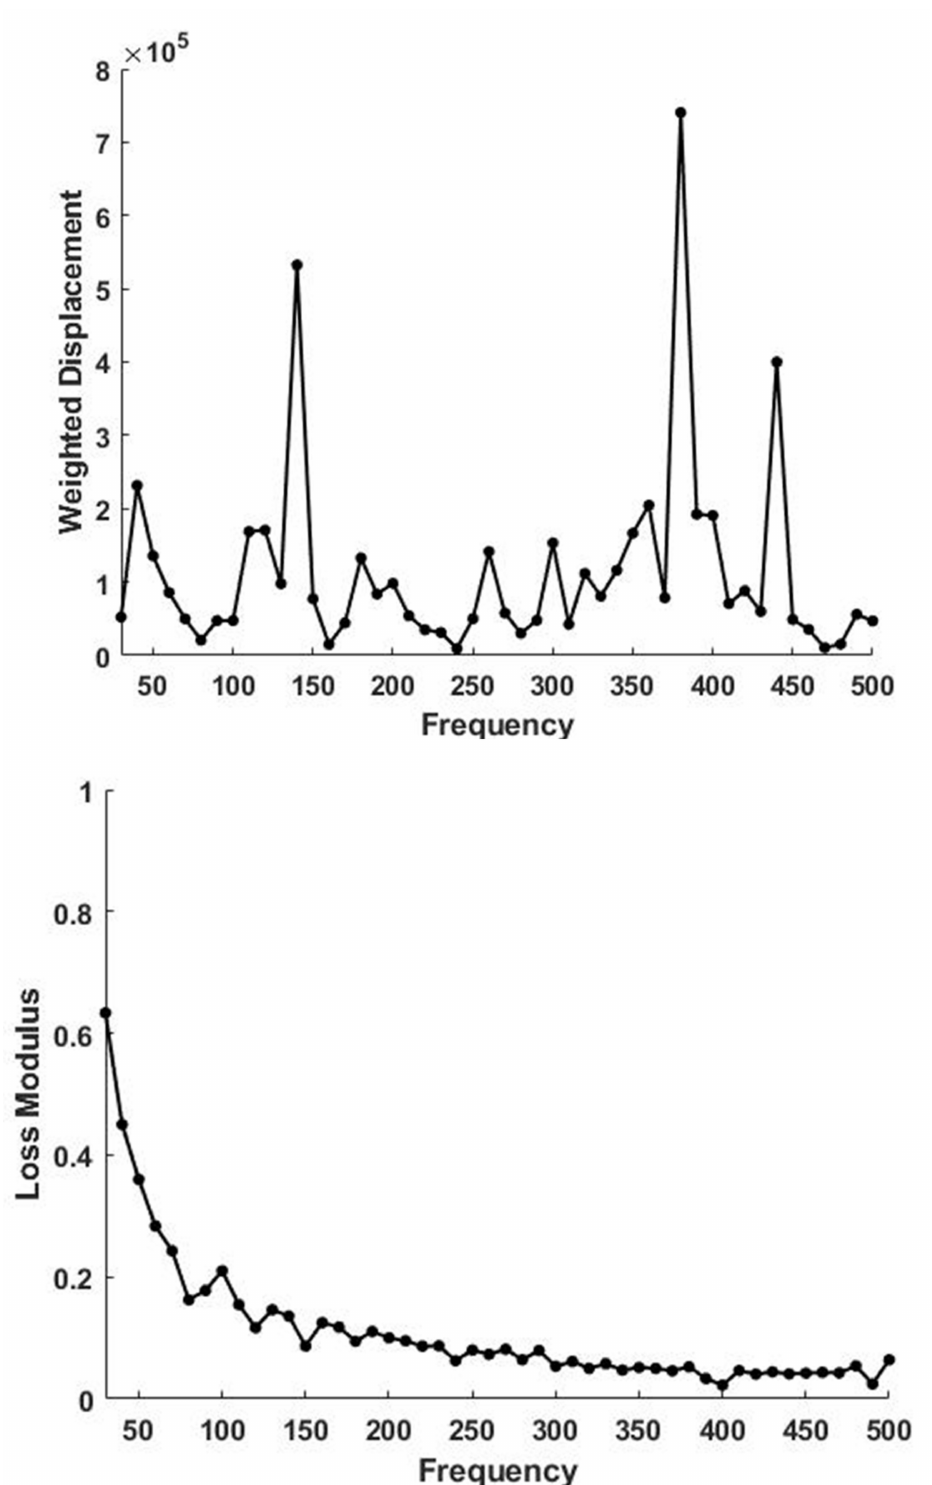
Figure 3. Weighted displacement in µ m vs. frequency in Hz for skin determined in vivo using VOCT ( top ). Note the presence of a normal dermal collagen peak at 120 Hz. The peaks at 70, 140, 380 and 440 Hz are due to the cellular contribution, vascular, muscle and tendon contributions based on Table 1. A plot of loss modulus as a % of the elastic modulus versus frequency measured for skin over the biceps muscle is shown ( bottom ). Note the loss modulus is maximized at low frequencies and is much higher than that of decellularized